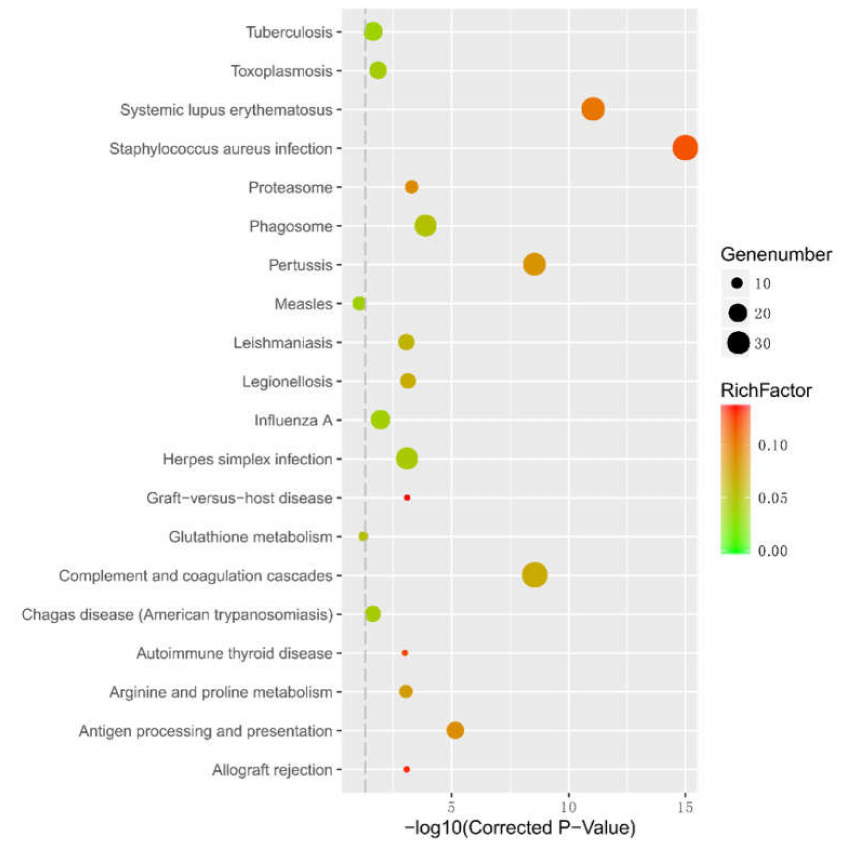
Figure 7. Glucose metabolic-related KEGG pathways for differentially expressed genes responded to miR-34a inhibitor